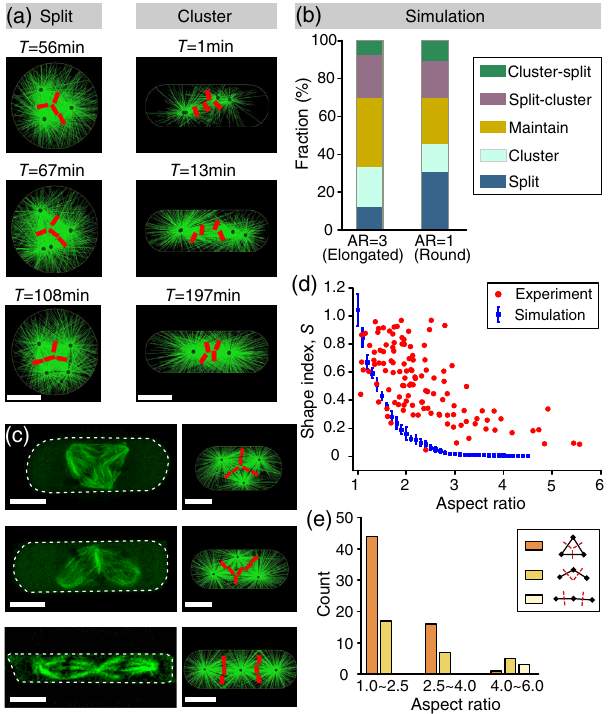
FIG. 4. Four-wall mechanical confinement controlling cell shape, which in turn regulates multipolar spindle configuration, and pole splitting and clustering. (a) Pole splitting and clustering process under four-wall confinement in simulation. The scale bar is 10 μ m. (b) Fraction of pole splitting, clustering, maintaining, splitting-clustering, and clustering-splitting under four-wall con- finement in simulation ( n ¼ 200 , 200). AR stands for aspect ratio. (c) Three typical configurations of tripolar spindles in cells with different aspect ratios from the experiment and simulation. The scale bar is 10 μ m. (d) Shape index of tripolar spindles as a function of cellular aspect ratio. (e) Quantity of three configu- rations of tripolar spindles in cells with different aspect ratios in the